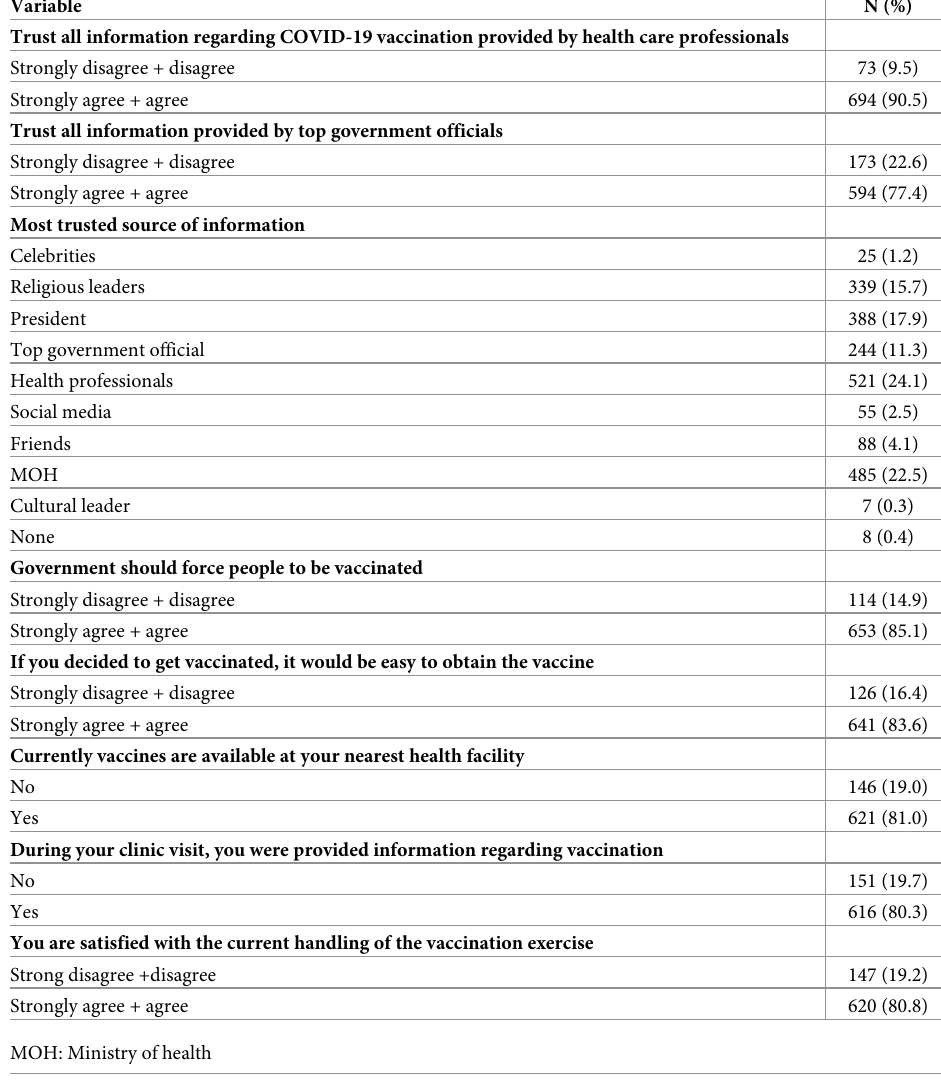
Table 4. Confidence in information sources, and convenience of vaccination program (N =